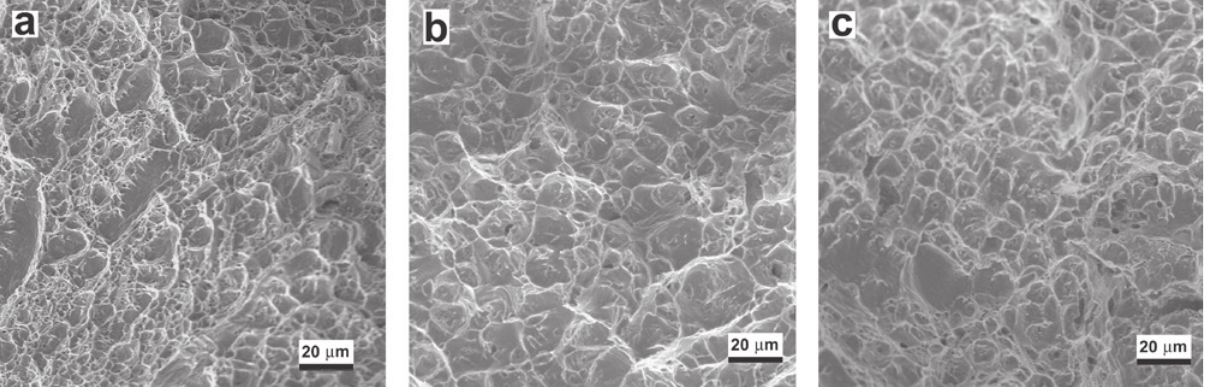
Fig. 5: SEM-fractographs of different regions of the welded joint T91/TP316H in PWHT state after the room-temperature tensile testing in condition without hydrogen charging: T91 steel HAZ (a), Ni WM Thermanit Nicro 82 (b), TP316H steel HAZ